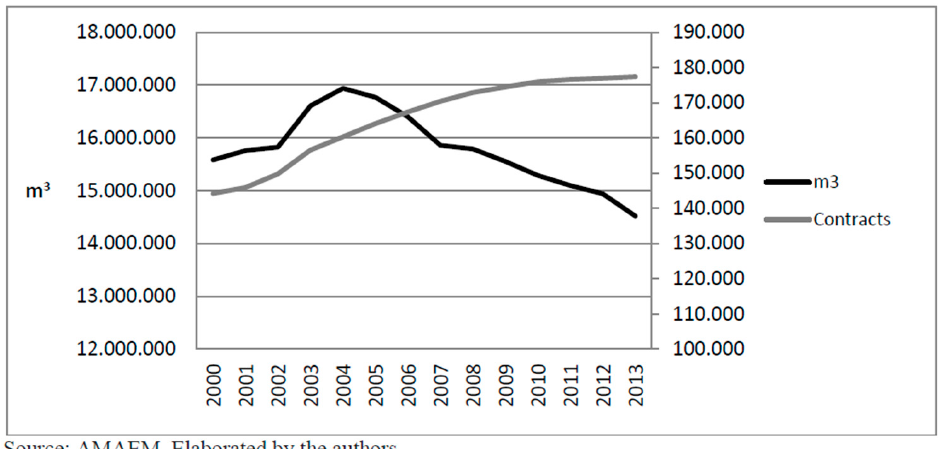
Figure 2. Evolution of domestic water consumption and number of water contracts in the city of Alicante, 2000–2013.